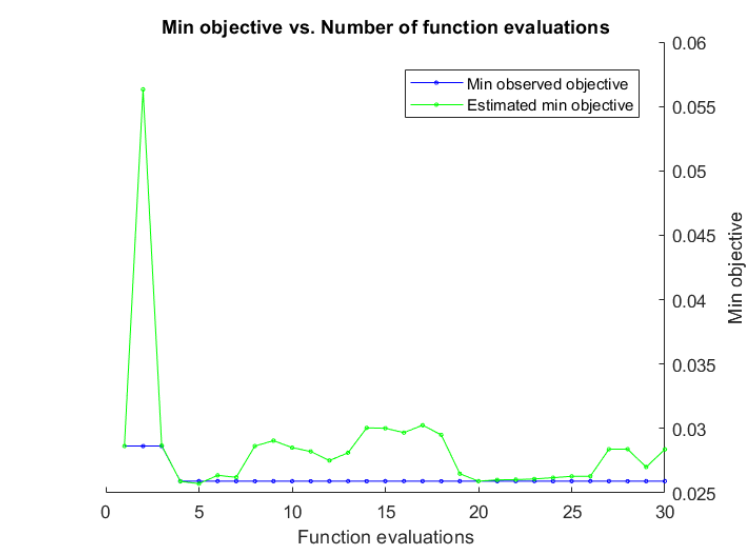
Figure 11. Objective function values throughout the optimization iterations plot in Experiment 2.